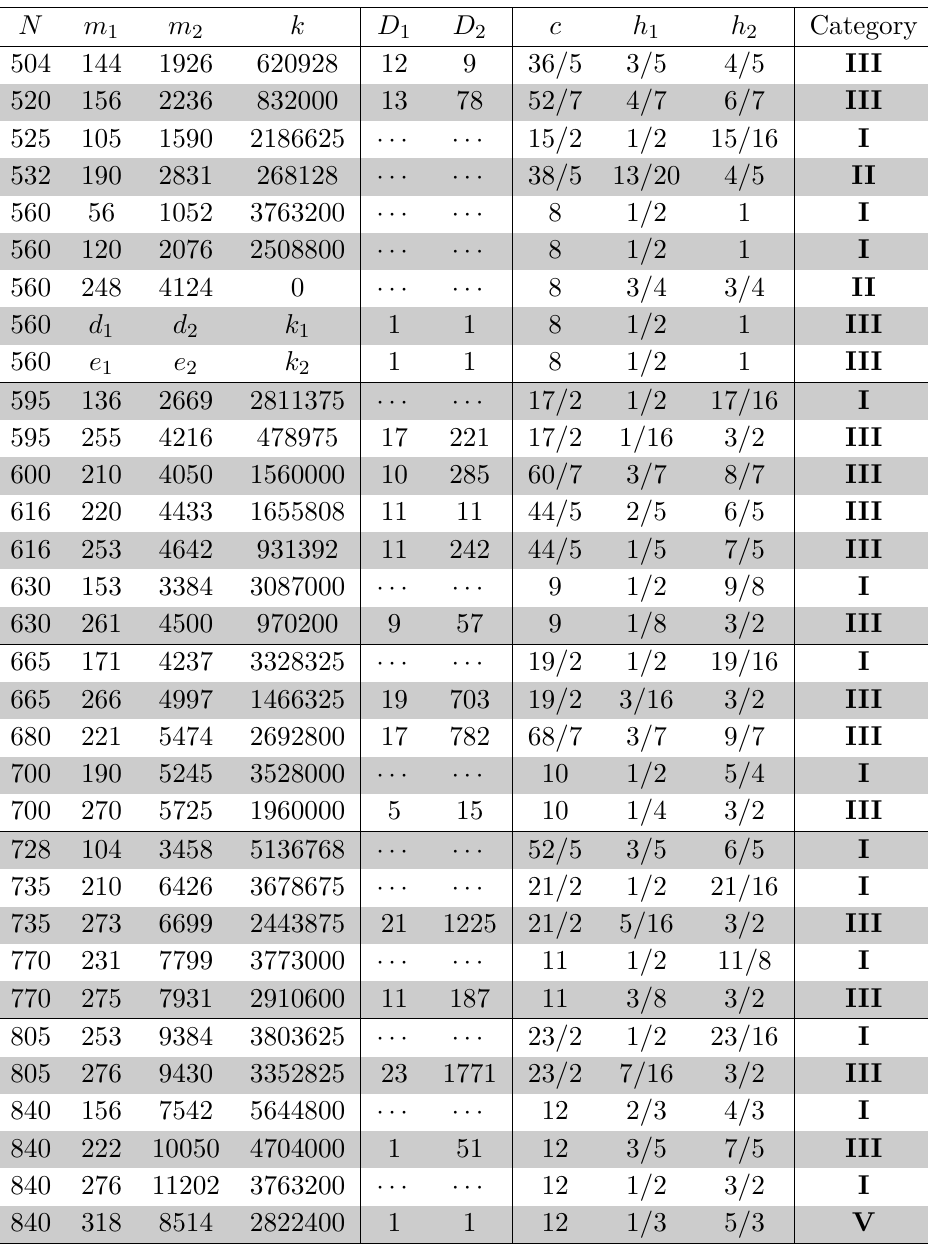
Table 12 . Solutions to the [ 3 , 0 ] MLDE with 7 < c ≤ 12